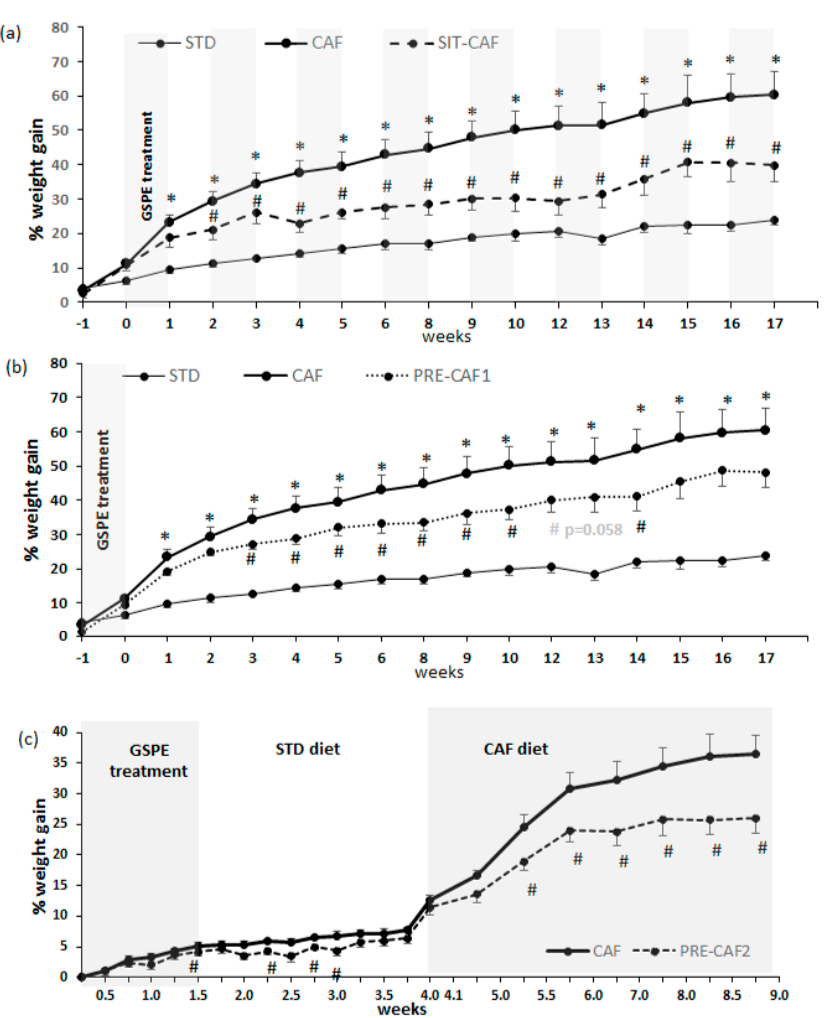
Figure 2. Body weight gain during the experiment. Body weight was measured weekly throughout the whole experiment. STD: lean rats fed a standard chow diet; CAF: rats fed a cafeteria diet; PRE-CAF1: rats receiving GSPE preventive treatment 10 days before the cafeteria intervention started; PRE-CAF2: rats receiving GSPE preventive treatment for 10 days together with a high fat/high sucrose diet followed by the cafeteria diet intervention; SIT-CAF: rats receiving GSPE treatment simultaneously and intermittently with the cafeteria diet every other week. Values are means ± SEM. * p < 0.05 compared to STD rats. # p < 0.05 compared to the CAF